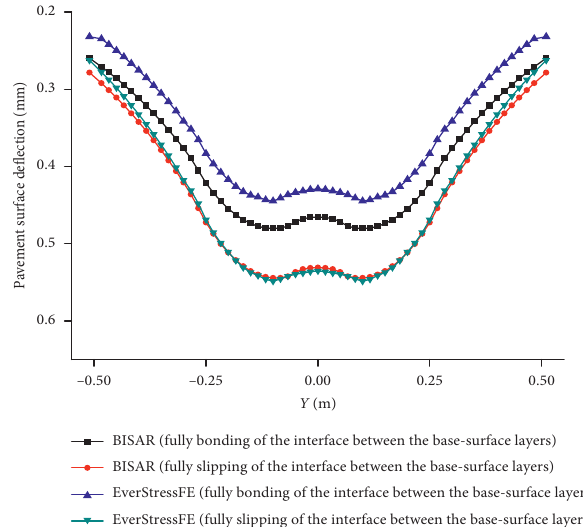
Figure 7: Distribution of pavement surface deflections of the two programs at X � 0 (unit: